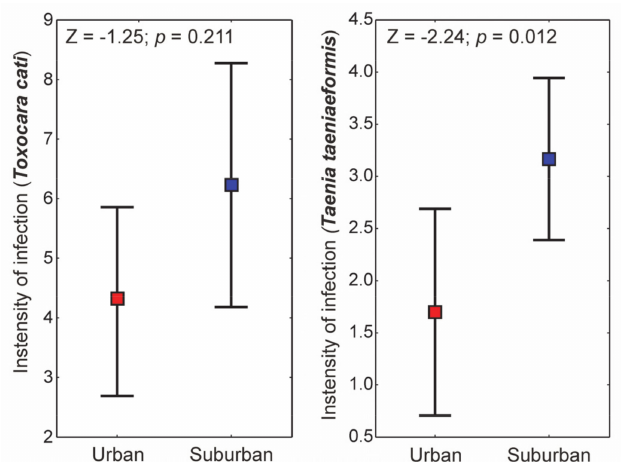
Figure 1. Whisker plots (mean ± SE) of intensity of infection in the two most common parasites of cats in urban and suburban areas. The results of Mann–Whitney U tests are provided in the inset of the graph.